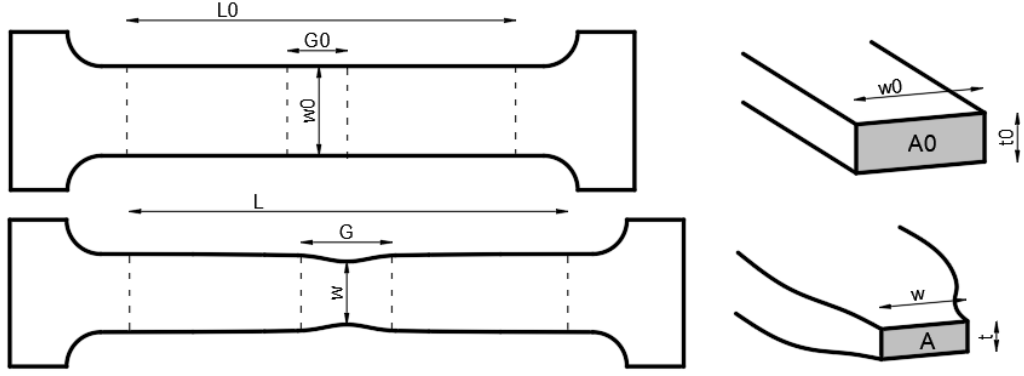
Figure 4. Possible geometrical parameters for true stress–true strain evaluations.